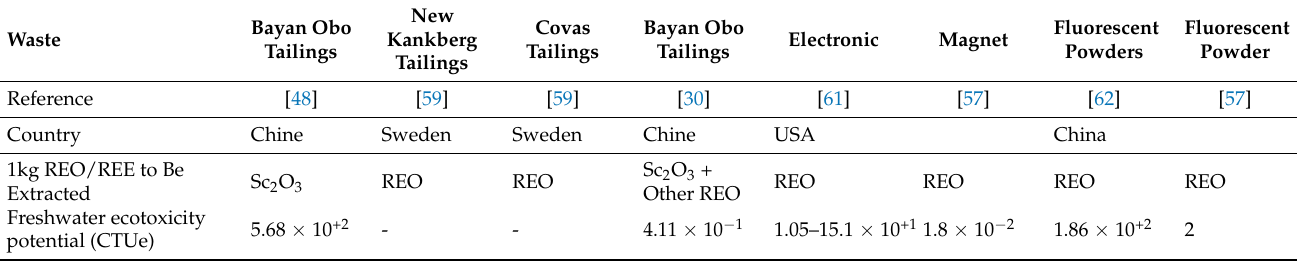
Table A4. LCA of the production of REE from secondary